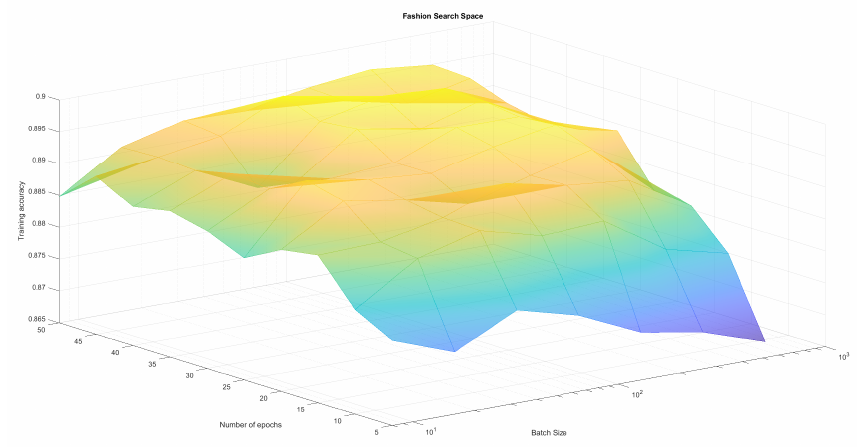
Figure 4. Epoch and batch search space for Fashion-MNIST classification. We cannot observe one clear maximum, but there are areas that should be avoided.